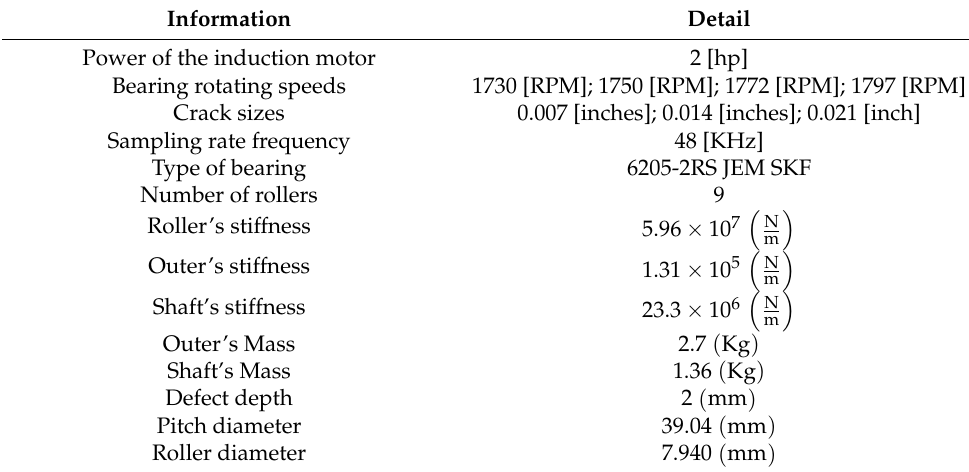
Table 1. The CWRUBD experimental information.